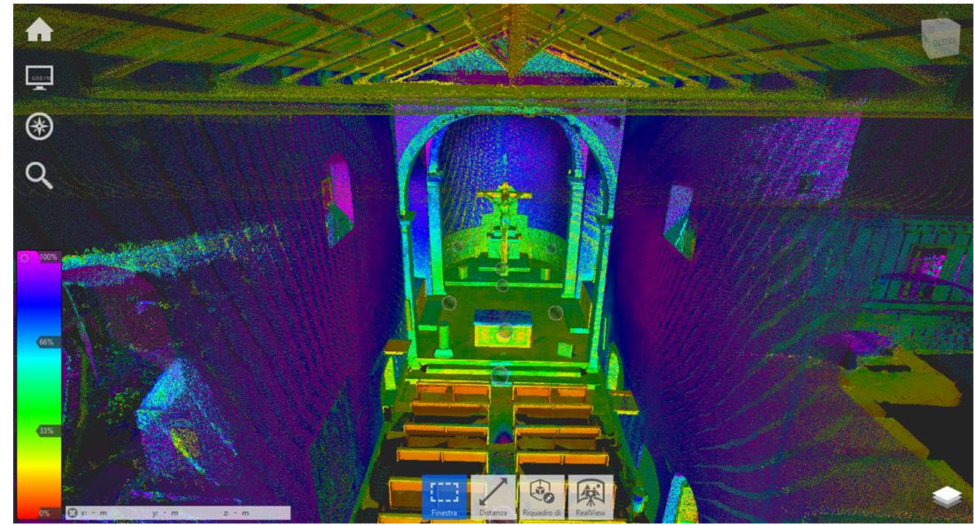
Figure 17. Recap elaboration: intensity map of the internal